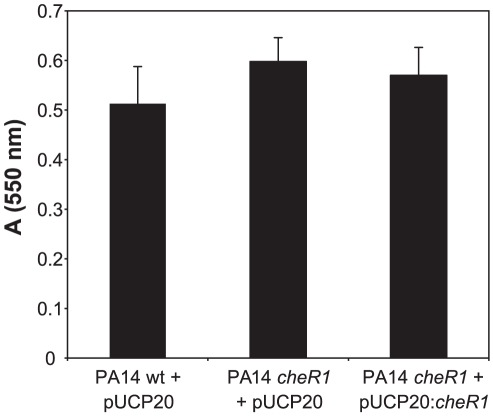
Crystal violet (CV) staining assay for the determination of attached biomass.PA14 wild-type carrying the vector control (pUCP20), the PA14 cheR1 mutant carrying the vector control (pUCP20) and the complemented PA14 cheR1 mutant (carrying pUCP20:cheR1) were grown in LB for 24 h at 37°C under static conditions before staining with CV. Representative data from one experiment out of five are shown. Error bars are standard deviations of eight replica.